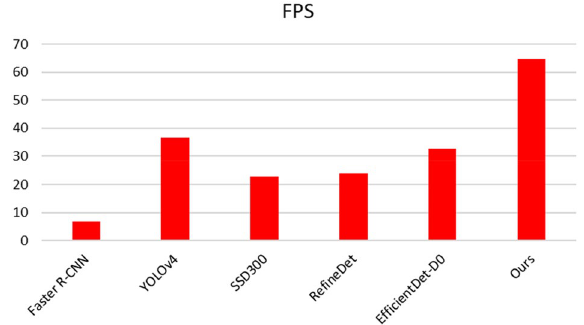
Figure 10. Comparison of efficiency with other advanced algorithms.